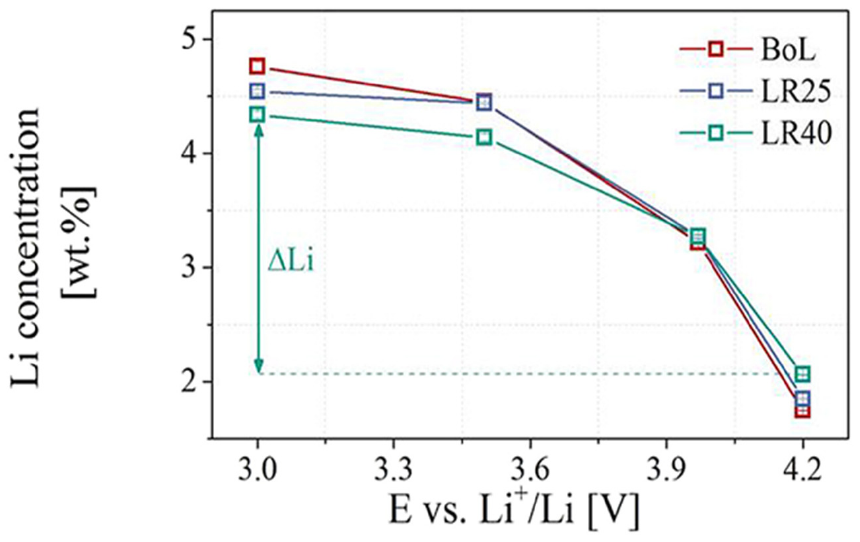
Figure 16. Lithium concentration measure by ICP-OES [77].